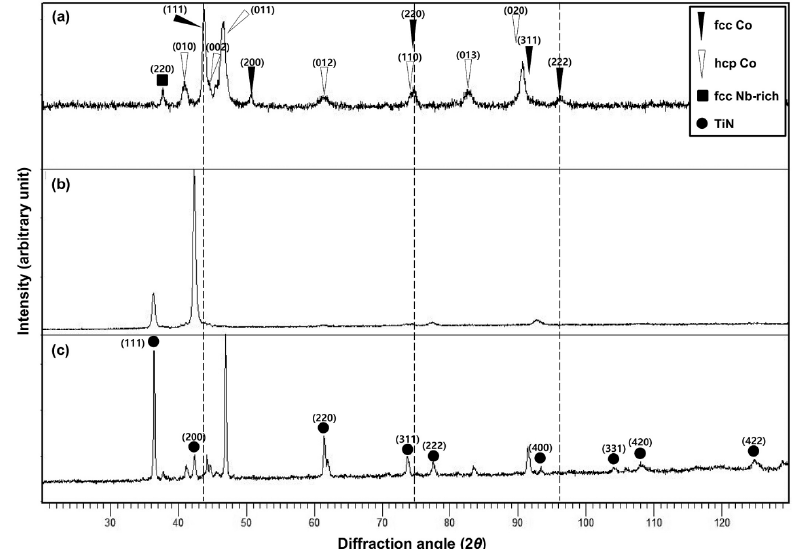
Figure 2. X-ray di ff ractometry (XRD) patterns and phases of the mirror-polished Co–Cr alloy (substrate) Figure 2. X-ray diffractometry (XRD) patterns and phases of the mirror-polished Co–Cr alloy specimen ( a ) and the PVD ( b ) and CVD ( c ) TiN-deposited (substrate) specimen ( a ) and the PVD ( b ) and CVD ( c ) TiN-deposited specimens.